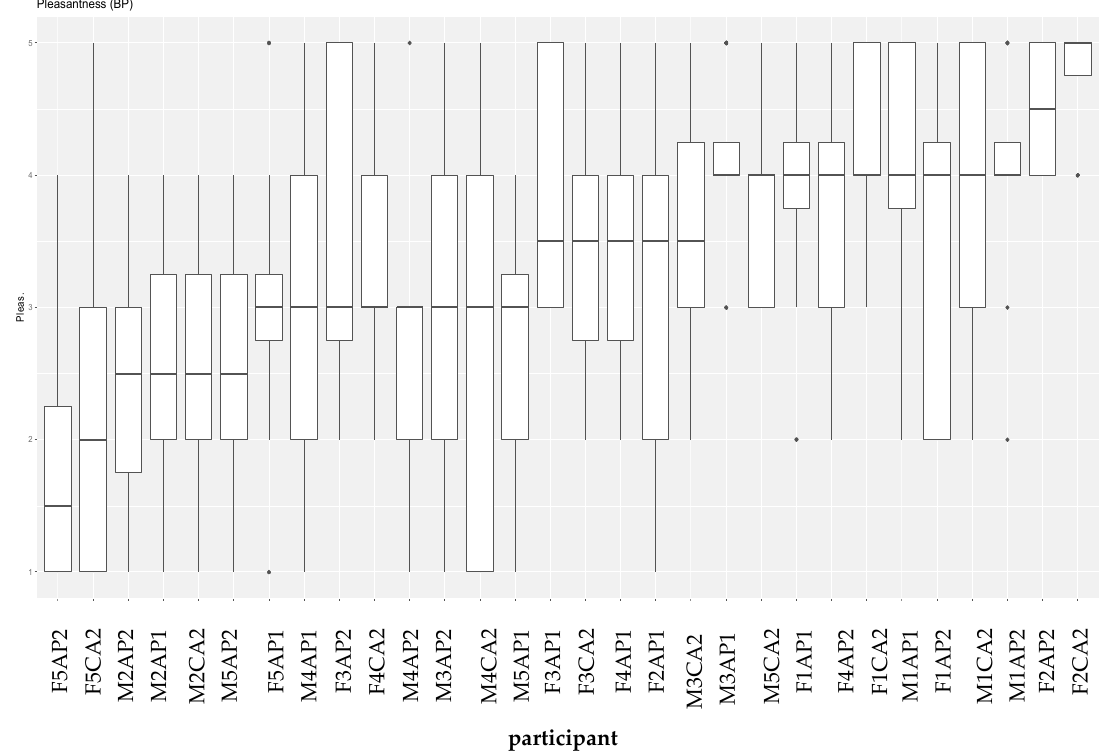
Figure 9. Pleasantness degree boxplots for BP declamations for each reciter and poem.